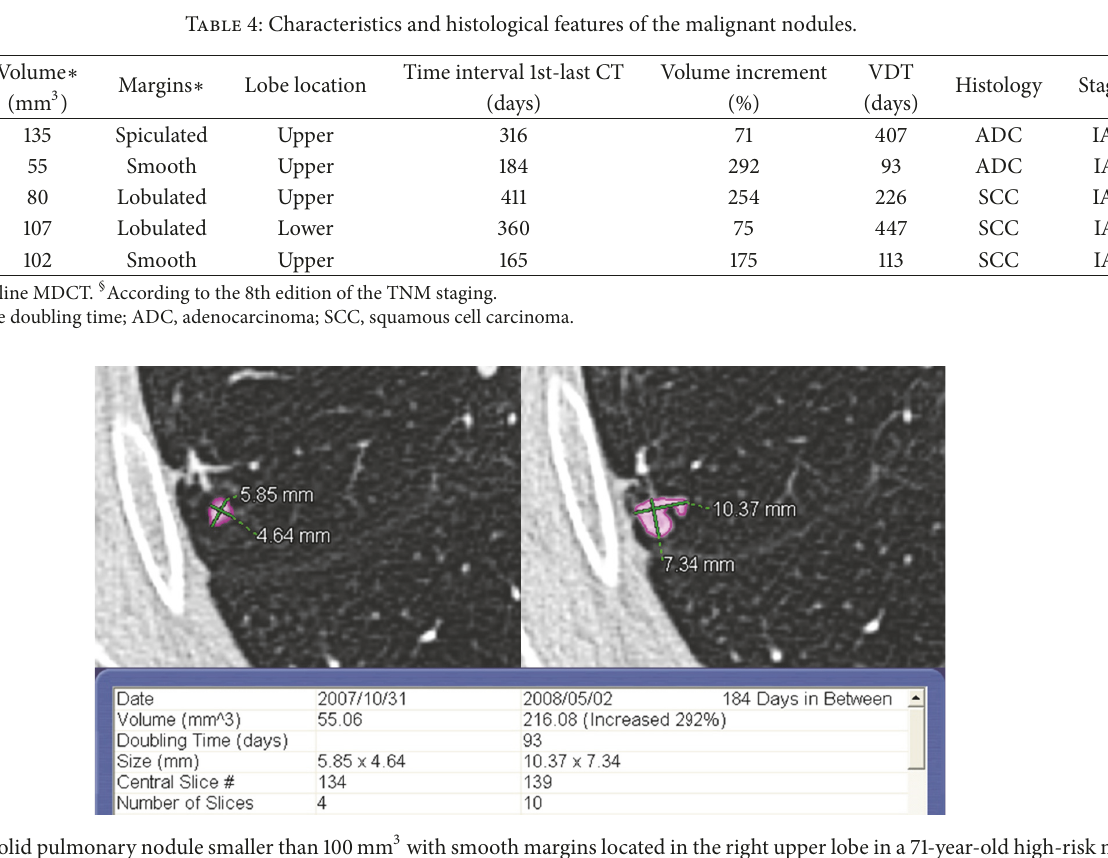
Figure 1: Solid pulmonary nodule smaller than 100 mm 3 with smooth margins located in the right upper lobe in a 71-year-old high-risk male patient. Baseline (left) and follow-up CT scans (right). The interval between the two CT examinations was 184 days. The software calculated significant growth between the baseline and follow-up CT scans with a relative volume variation of 292% (from 55 mm 3 to 216 mm 3 ) and a volume doubling time of 93 days. The nodule was surgically removed and proven to be a pulmonary adenocarcinoma. In this case, the new Fleischner Society guidelines would have recommended a follow-up CT examination at 12